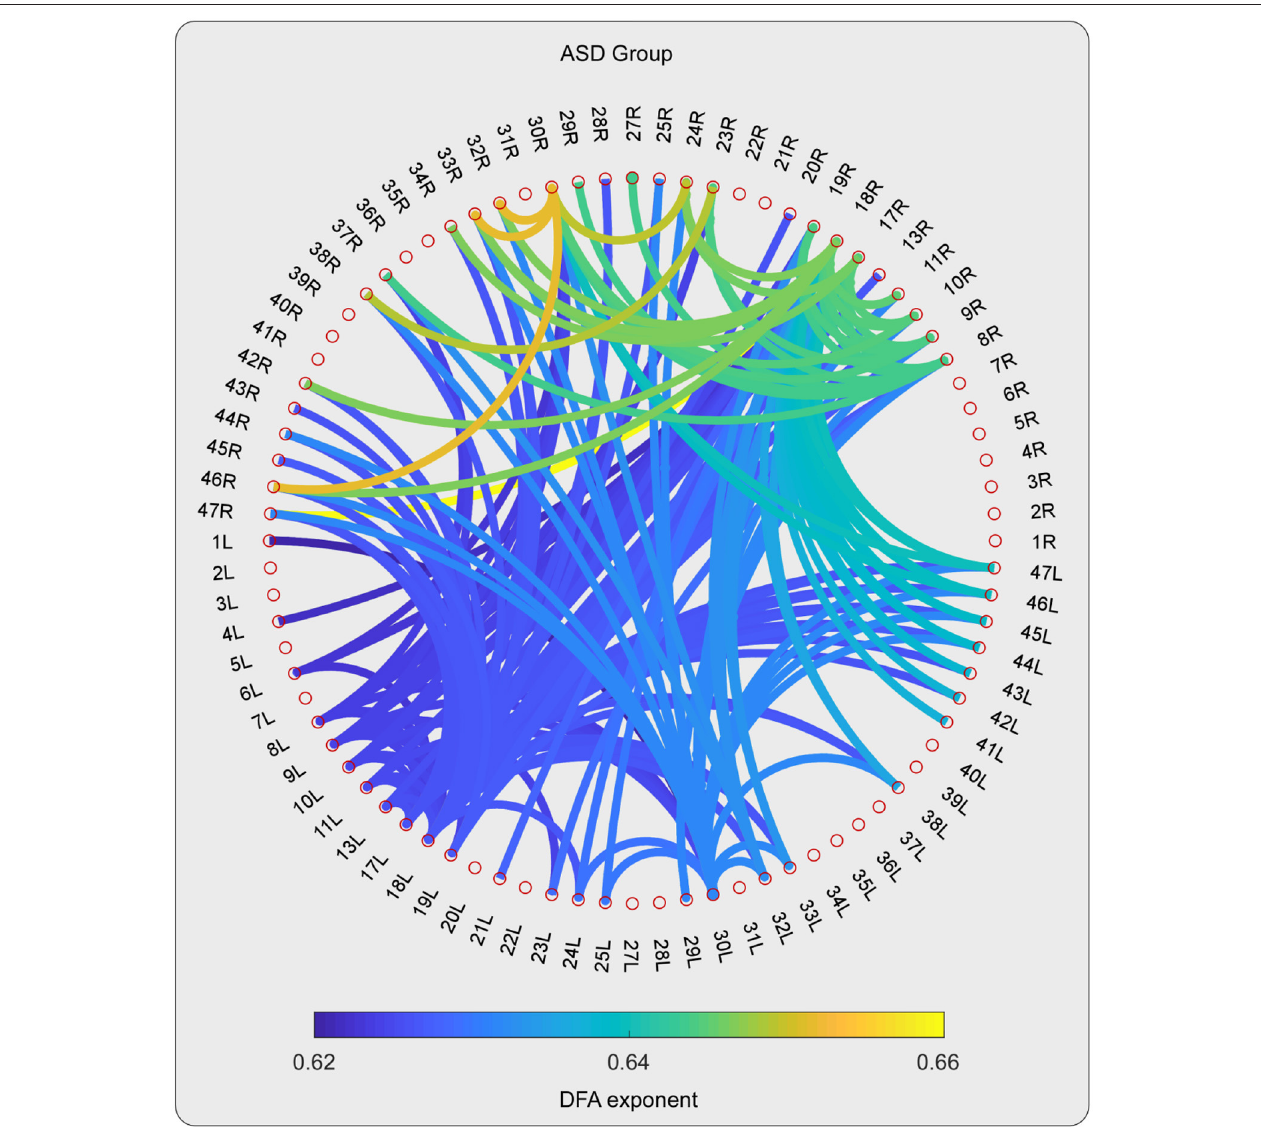
FIGURE 2 | The DFA exponents of TV-PS time series in high-gamma oscillations for ASD group. The magnitude of DFA exponent is color coded. Note that, only the pairs with 10% largest DFA exponent are